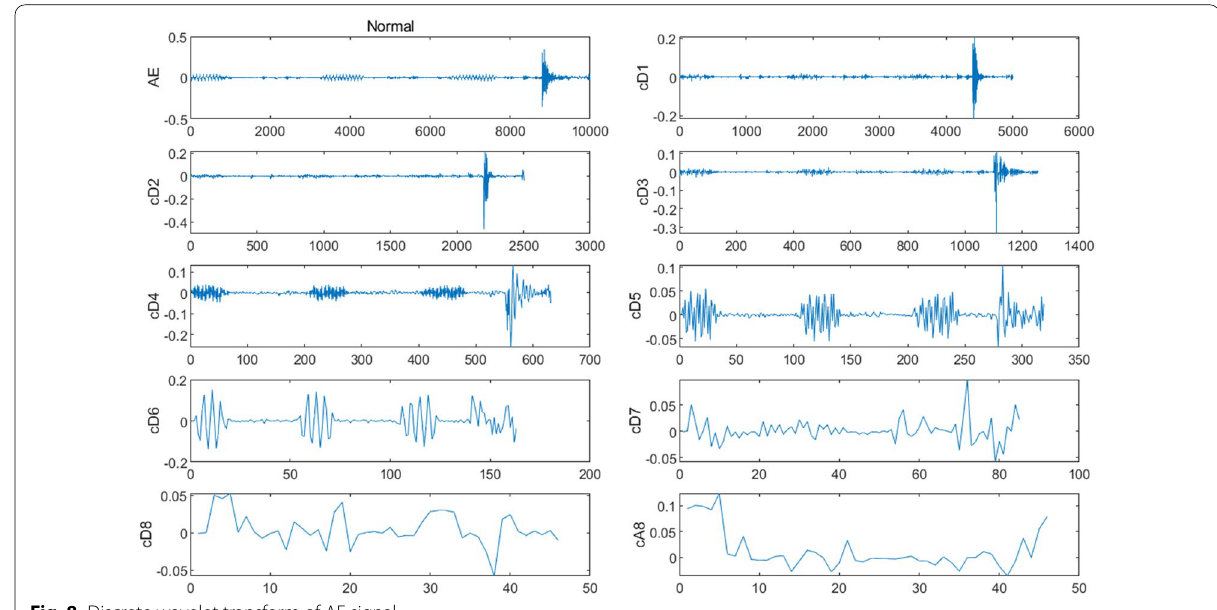
Fig. 8 Discrete wavelet transform of AE signal